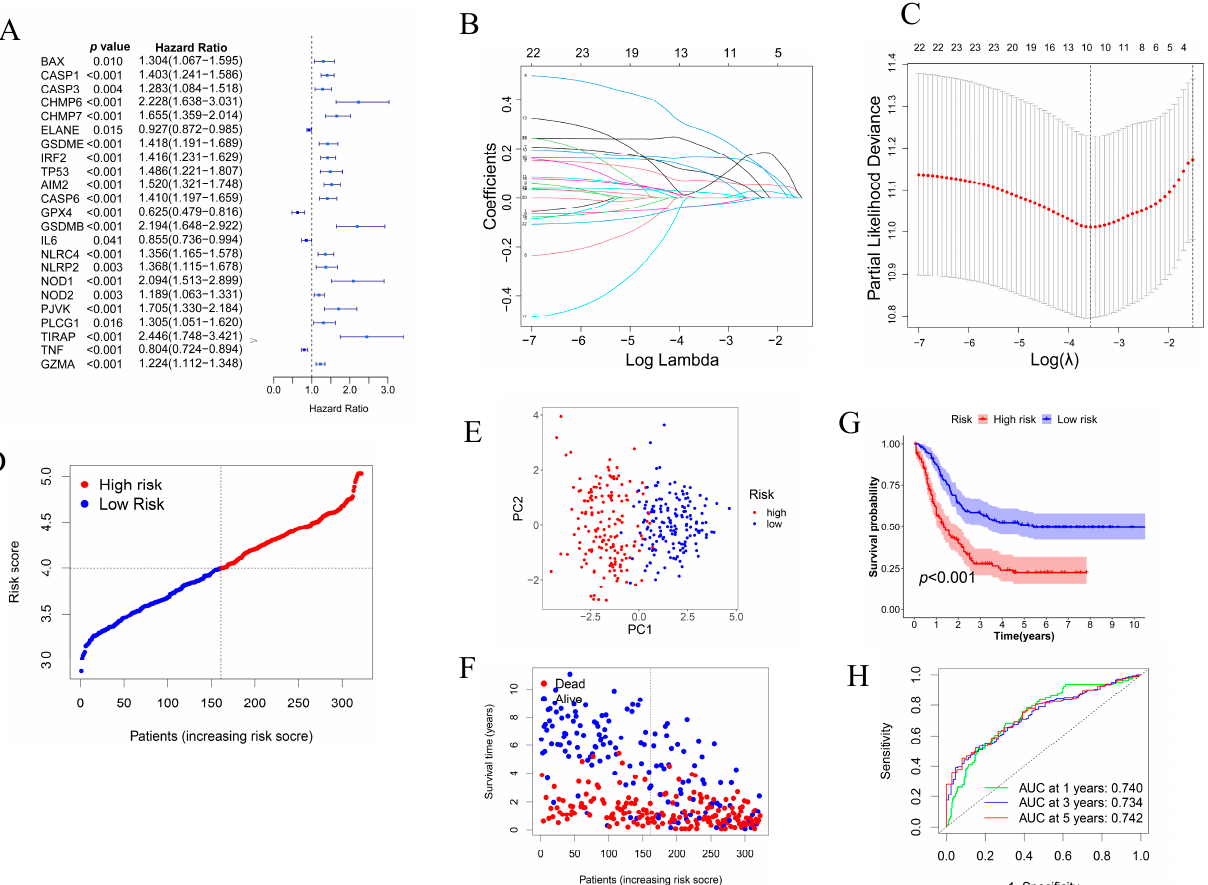
Figure 3. Establishment of a risk signature model of AML patients in the TCGA-TARGET cohort. ( A ) Univariate cox regression analysis of OS for the statistically different expressed pyroptosis-related gene, the results were shown as a forest plot, and 23 genes with p < 0.05. ( B ) LASSO -COX regression of the 23 survival-related genes. ( C ) Cross-validation for the tuning parameter ( λ ) selection in the LASSO regression. ( D ) Distribution of AML patients based on their risk scores. ( E ) PCA plot for AML patients based on the risk score. ( F ) Distribution of survival status of AML patients. ( G ) Kaplan-Meier survival curve for the high-risk and low-risk groups. ( H ) The time-dependent ROC curves showed the predictive efficiency of the risk signature